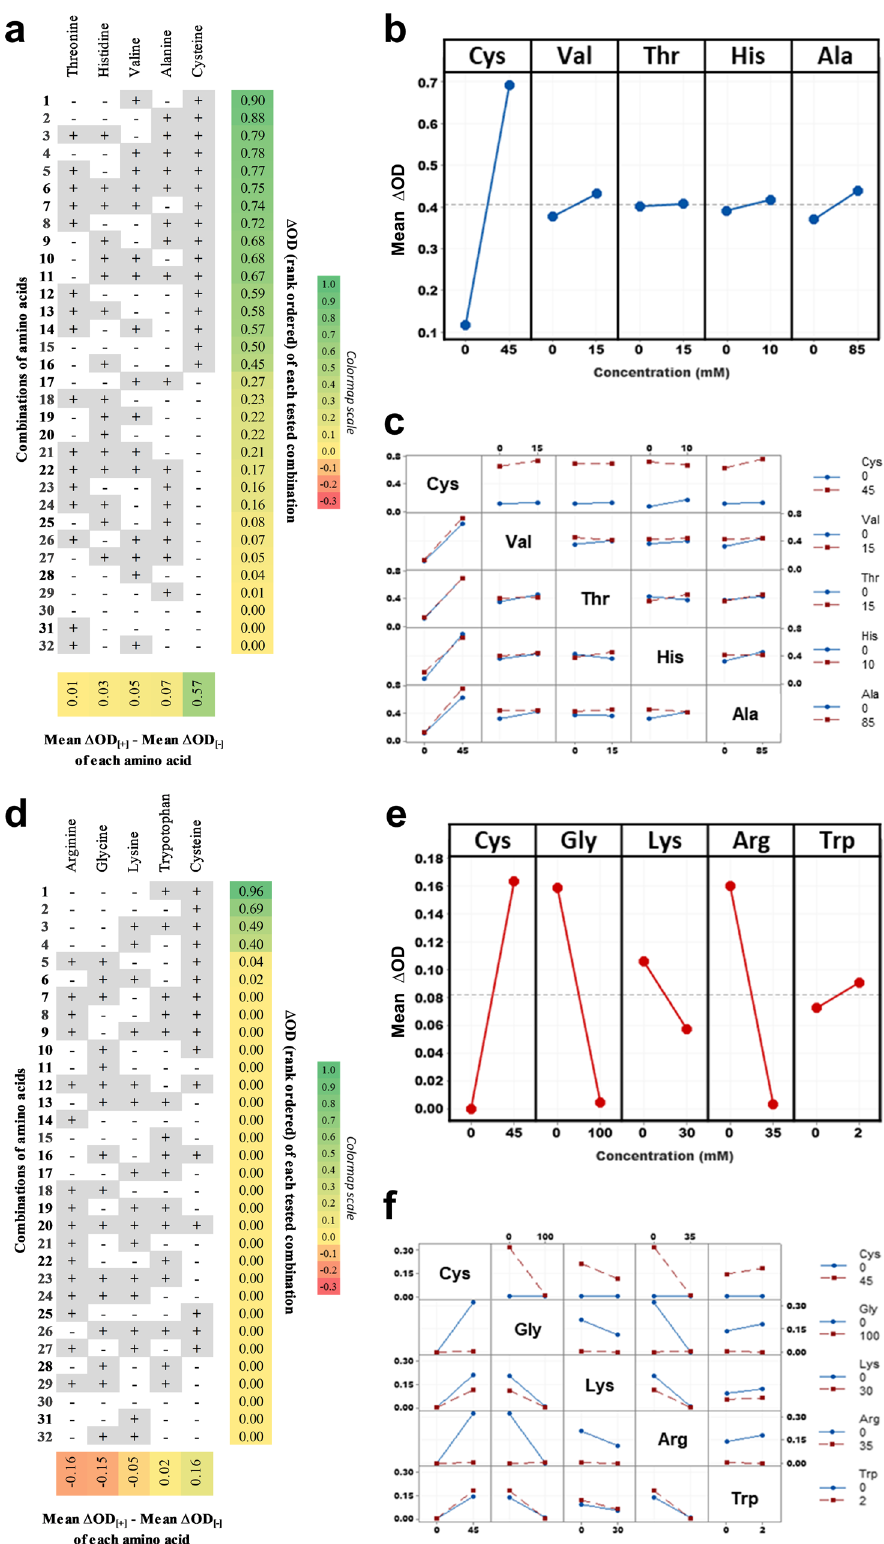
present. The alternative visualization in Fig. 2e, con fi rms this observation, and further reveals a weaker interaction with L-lysine. This intuition is further reinforced by the secondary interaction plot (Fig. 2f), which shows non-parallel blue and red lines for multiple box graphs. As expected, a deviation from